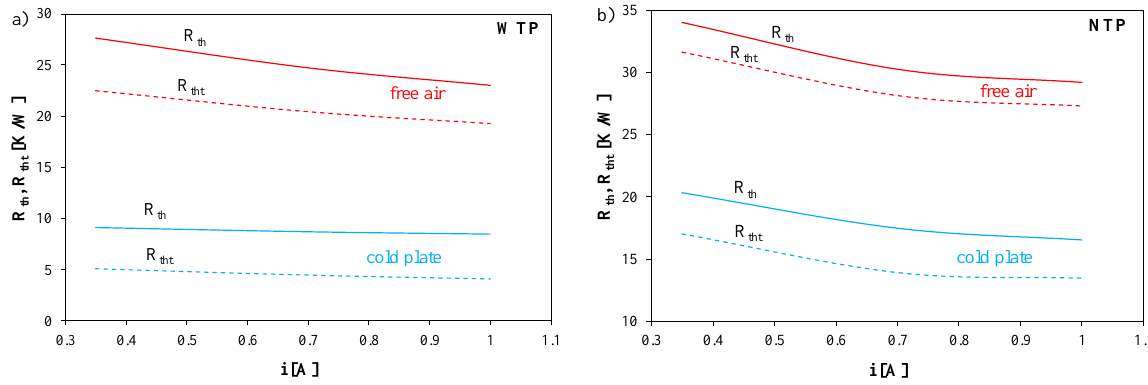
Figure 13. Dependences of self thermal resistance (solid lines) and transfer thermal resistance (dotted lines) between diodes contained in the MCE device on forward current for the device mounted with the use of a thermal pad ( a ) and without a thermal pad ( b ) obtained using the custom set-up. Table 3. Thermal power, optical power, and thermal resistance of the tested power LEDs situated on the heat-sink.